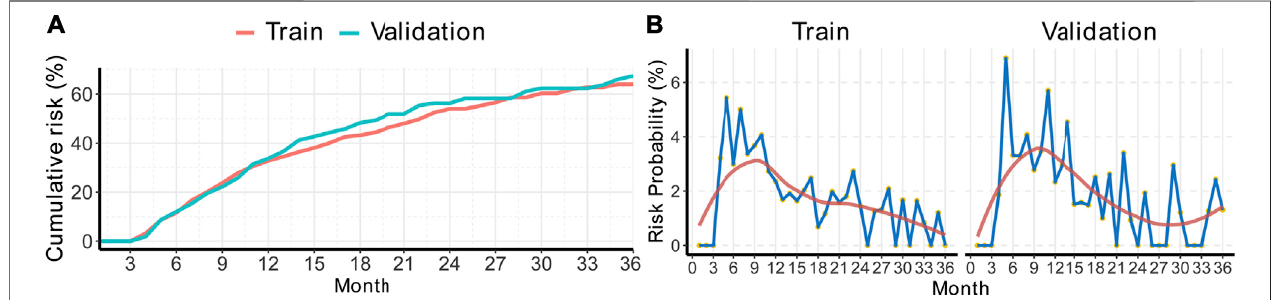
FIGURE 2 | Cumulative risk curves and time-speci fi c progression probabilities of BBHCC CR patients. (A) Cumulative risk curves. (B) Each month ’ s progression probability. BBHCC: Barcelona clinical liver cancer stage B hepatocellular carcinoma; CR: complete response.